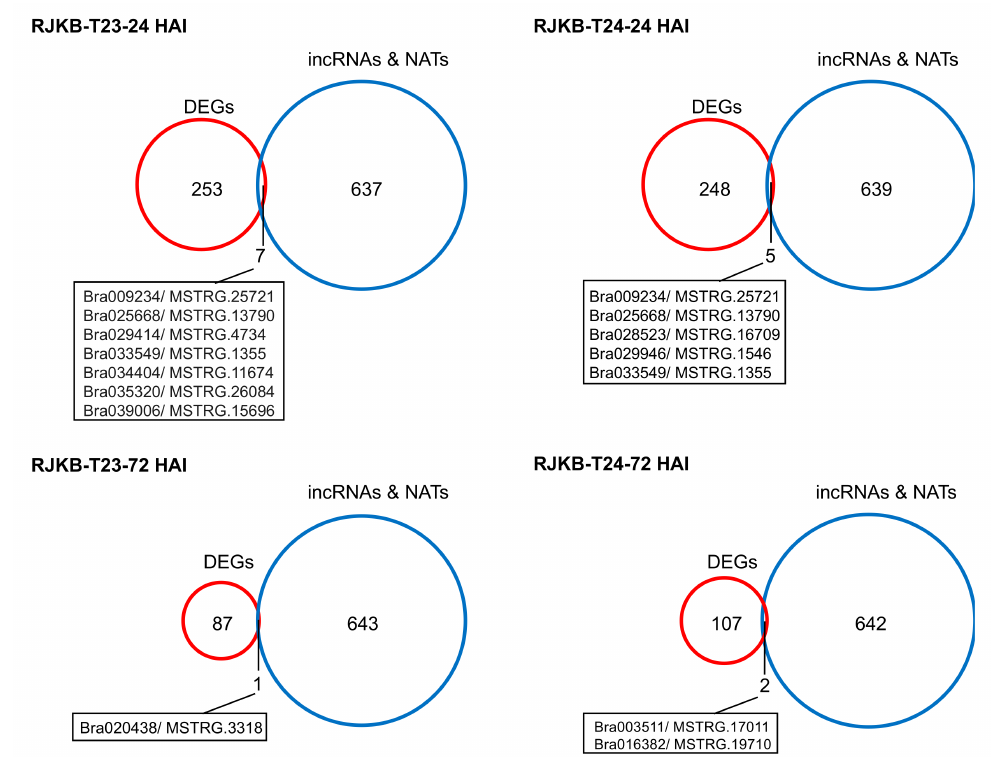
Figure 3. Venn diagrams between differentially expressed genes (DEGs) following F. oxysporum f. sp. conglutinans ( Foc ) and paired genes overlapping incRNAs or NATs. HAI of 24 or 72 indicates 24 or 72 h after Foc inoculation, respectively.